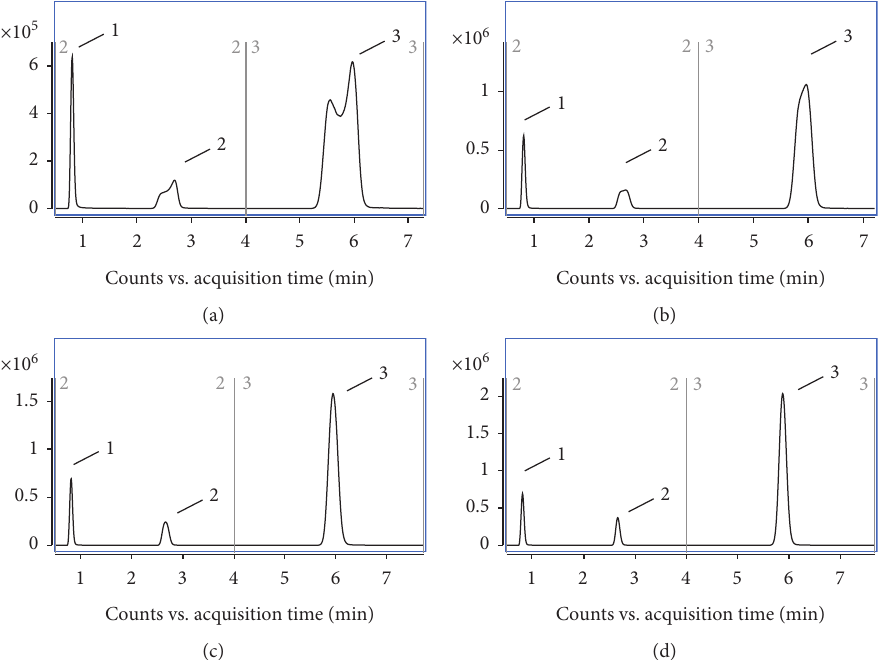
Figure 1: HPLC-MS/MS chromatograms of DFA (1.0mg/L, peak 1), 6-CNA (1.0mg/L, peak 2), and flupyradifurone (0.1mg/L, peak 3) on C 18 column and the same elution procedure under different injection solutions conditions. ((a) Acetonitrile: water � 1: 0 (v/v), (b) acetonitrile: water � 4:1 (v/v), (c) acetonitrile: water � 1 :1 (v/v), (d) acetonitrile: water � 1:4